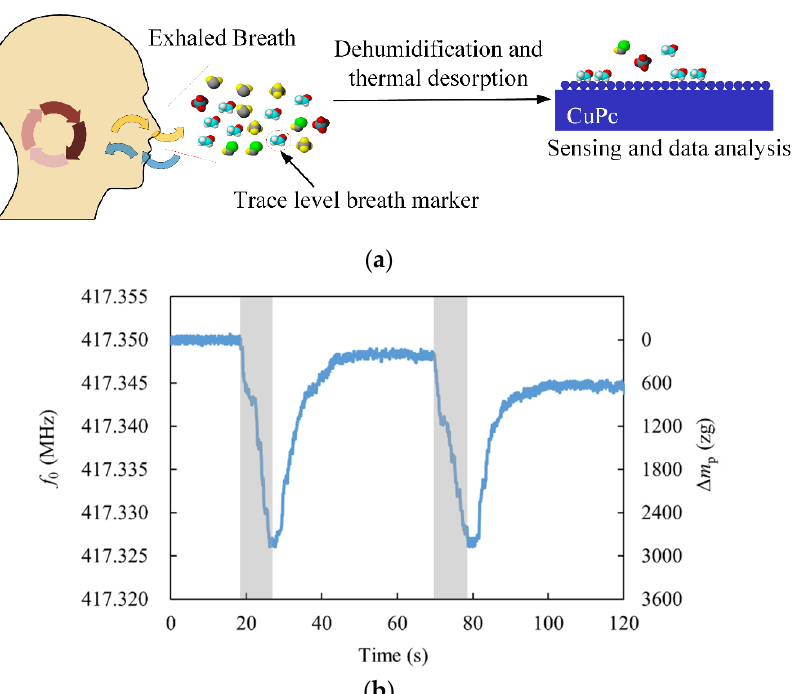
Figure 8. Detection of ethanol in human exhaled breath: ( a ) Schematic diagram of the sensor for detecting human exhaled air; ( b ) the response of the sensor to the detection of human exhaled gas twice in a